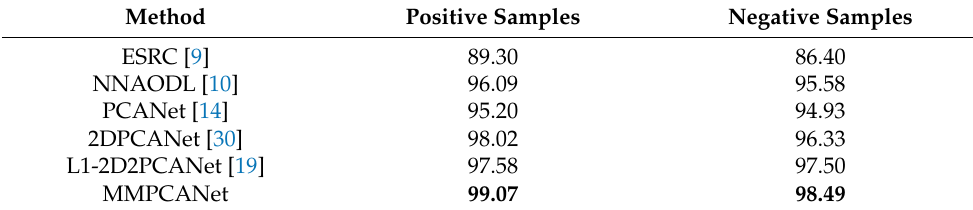
Table 3. Average Recognition Rate (%) on CelebA dataset.